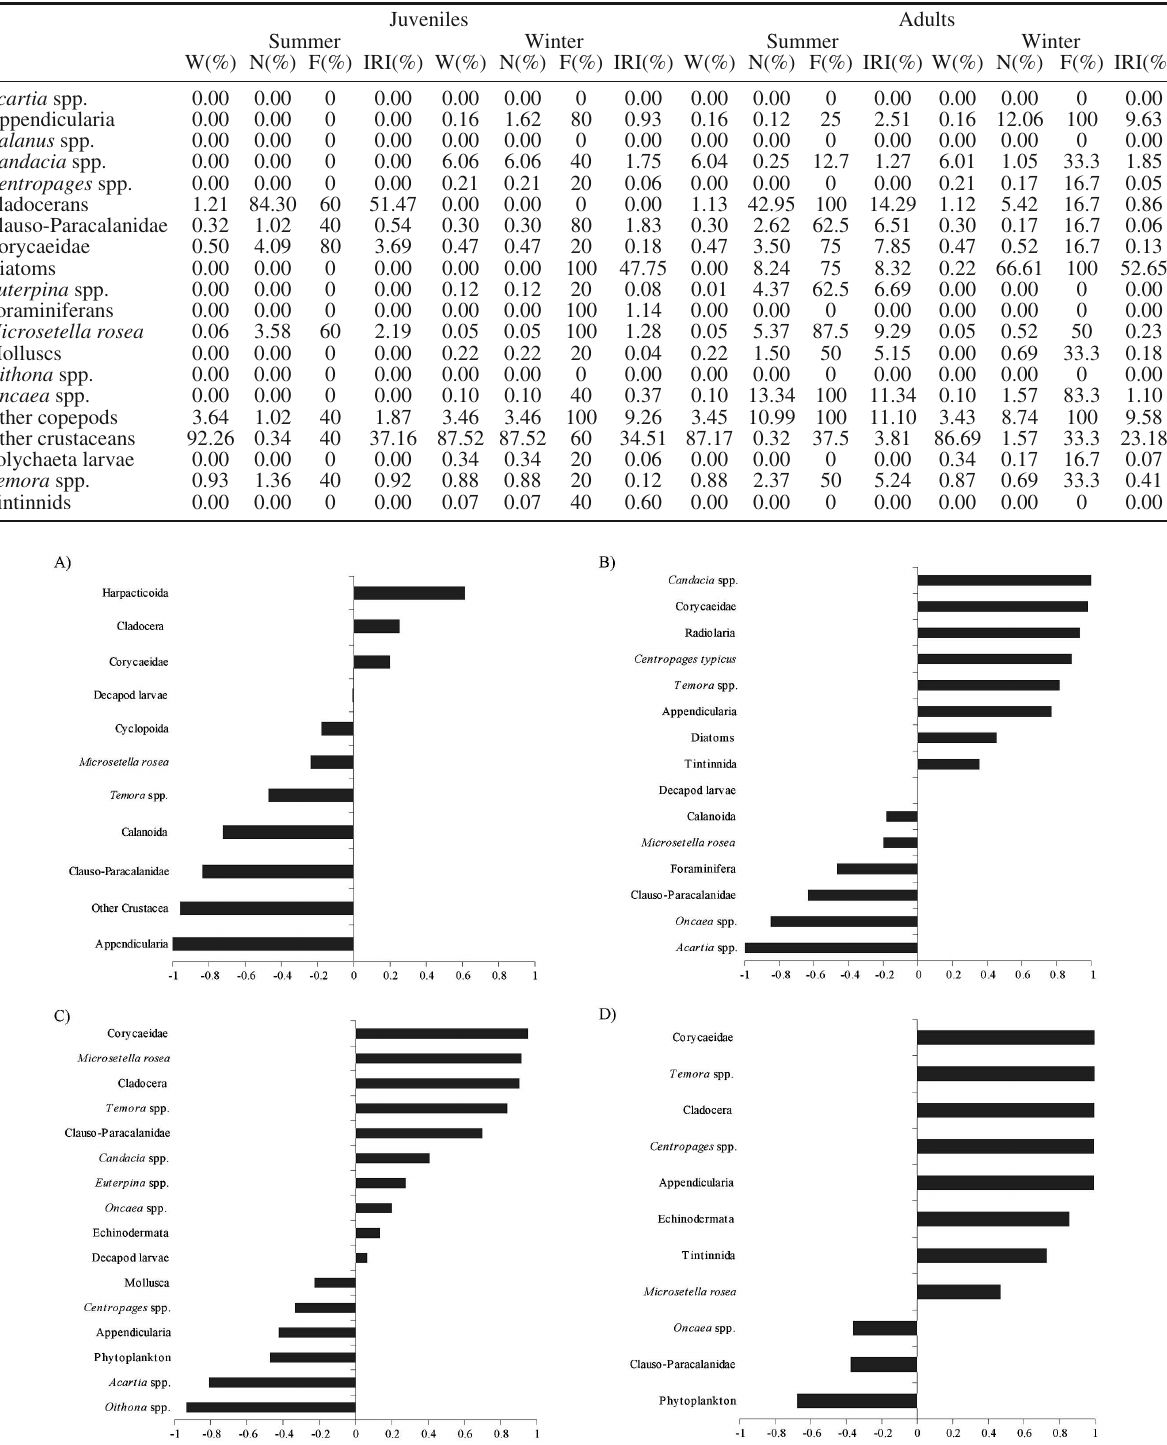
Table 4. – Total stomach contents by weight (W), numerical abundance (N) of prey, frequency of occurrence (F) of prey in the stomachs and index of relative importance (IRI). Juveniles Adults Summer Winter